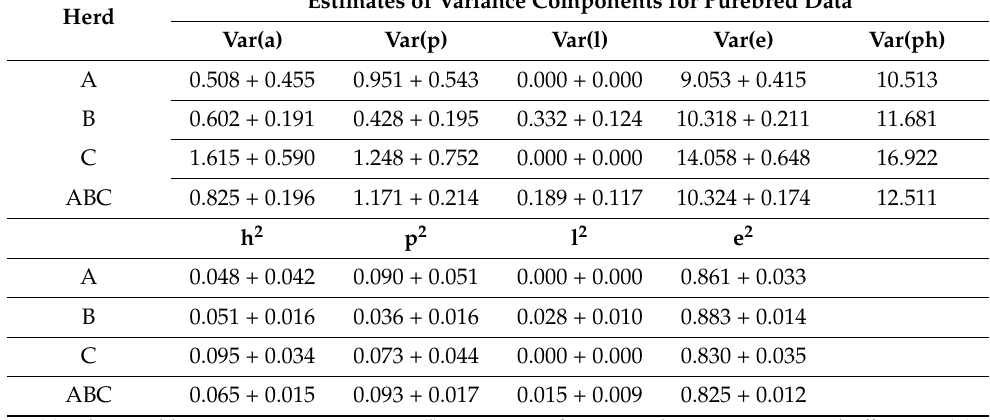
Table 2. Estimates of variance components and ratios with standard errors for NBA using purebred